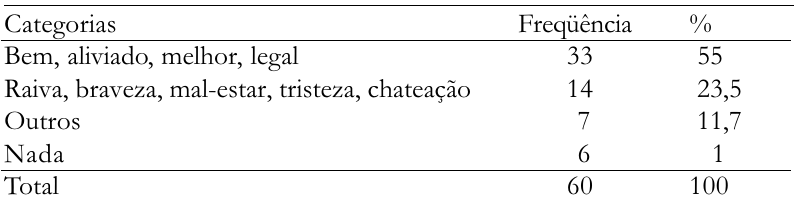
Freq(cid:252)Œncias e Percentagens das Respostas (cid:224) Pergunta: (cid:147)O que vocŒ sentiu depois que